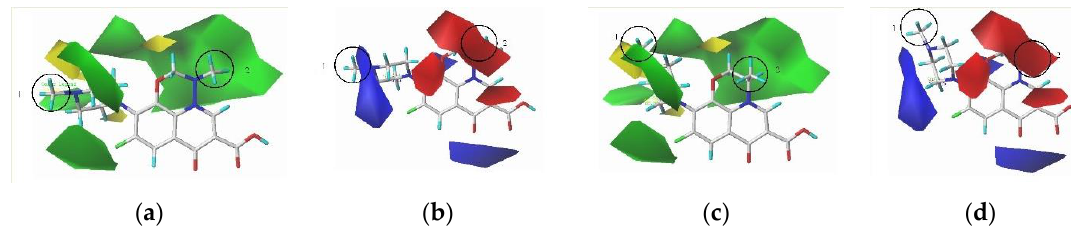
Figure 2. The contour maps of ( a ) Marbofloxacin (steric field), ( b ) marbofloxacin (electrostatic field), ( c ) levofloxacin (steric field), ( d ) levofloxacin (electrostatic field)